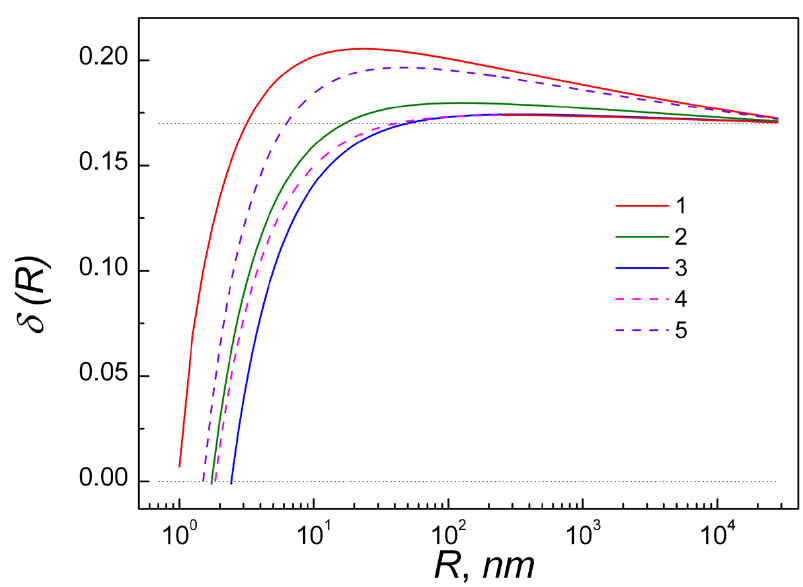
Figure 1. Relative thermal hysteresis as a function of the NP radius calculated by numerically solving Equation (10) for λ = 0 and for different values of α 0 [ nm ] and β 0 [ nm 2 ] : 1— α 0 = 0.2, β 0 = 0.1; 2— α 0 = 0.3, β 0 = 0.1; 3— α 0 = 0.4, β 0 = 0.1; 4— α 0 = 0.3, β 0 = 0.05; 5— α 0 = 0.3, β 0 =